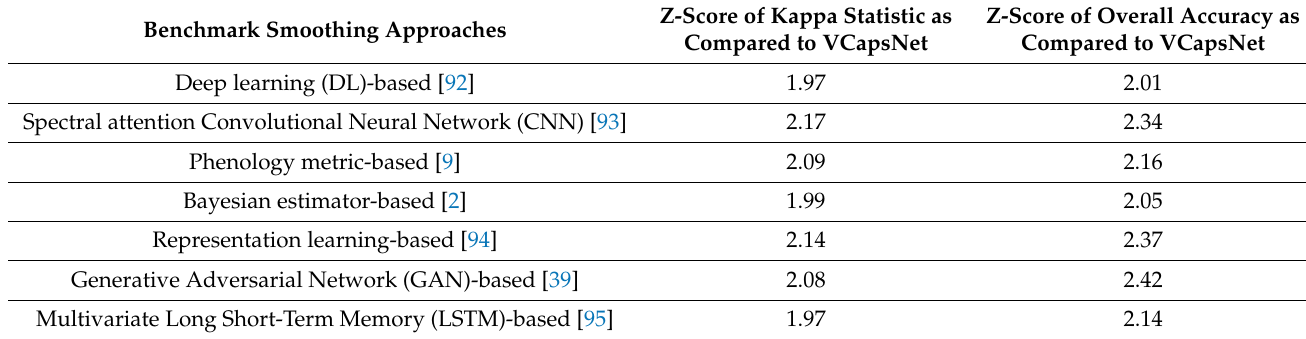
Table 6. Z-score-based significance analysis of the temporal validation of VCapsNet *. Benchmark Smoothing